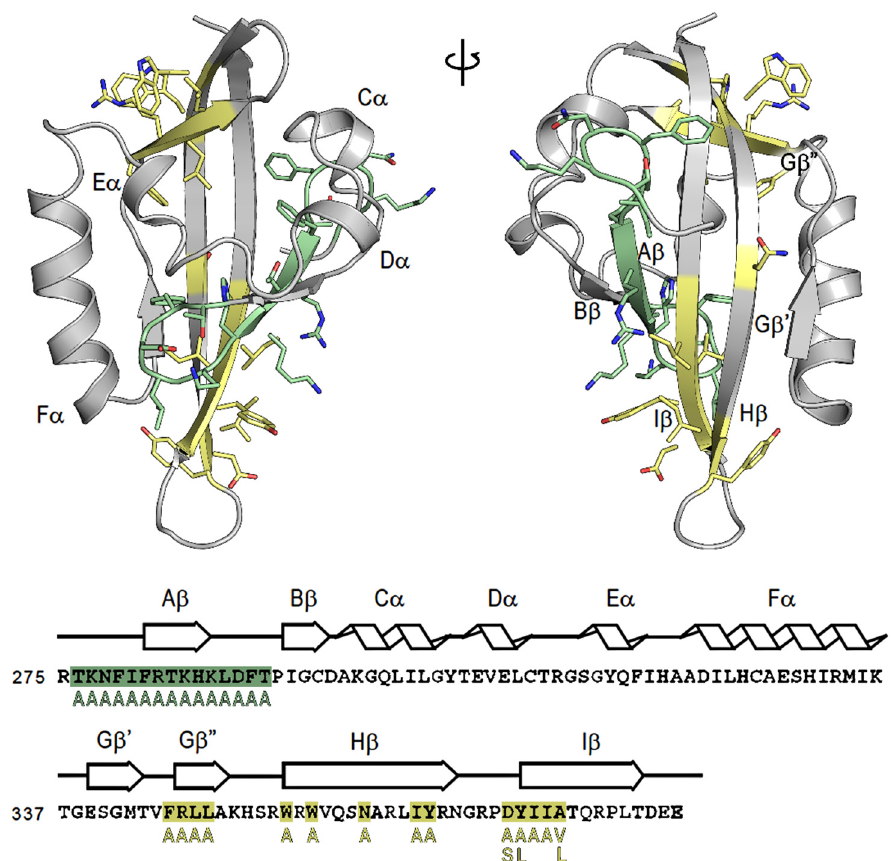
Figure 1. Structure and sequence of the mouse aryl hydrocarbon receptor (AhR) (Pubmed sequence: NP_038492.1) and map of generated mutations. The structure of the AhR PASB is taken from the homology model [33]. Structural elements of the AhR PASB homology model are indicated both in the structure and above the sequence. Mutants in A and B strands (N-terminal) are colored in green, while mutants in the G, H, and I strands (C-terminal) are colored in yellow.